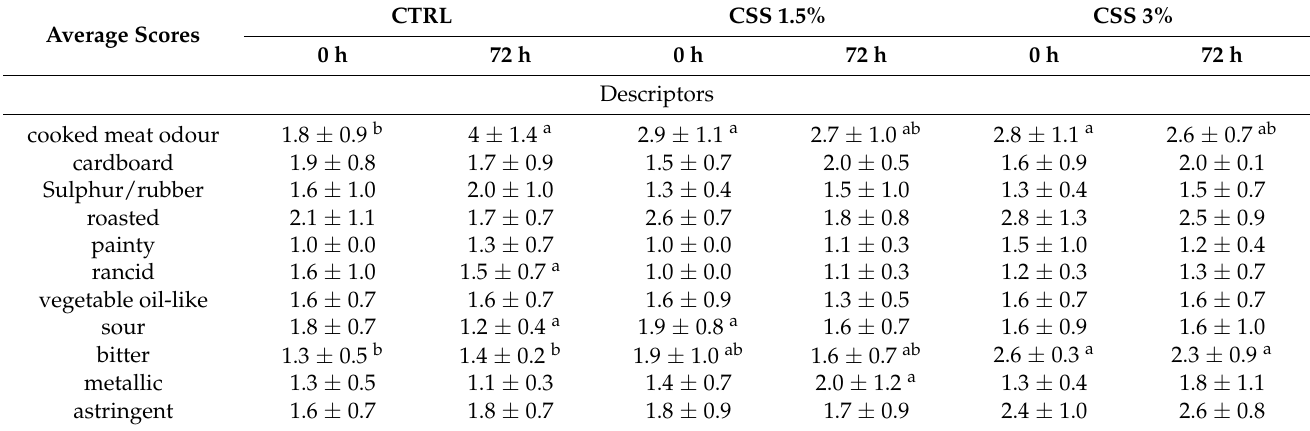
Table 5. Average scores for cooked CSS containing samples of panelists for each descriptor in all formulations; immediately after cooking process (T 0 ) and after 72 h of refrigerated (+4 ◦ C) storage (T 72 ). CTRL CSS 1.5% CSS 3% Average Scores 0 h 72